Question: Describe this figure in one sentence.
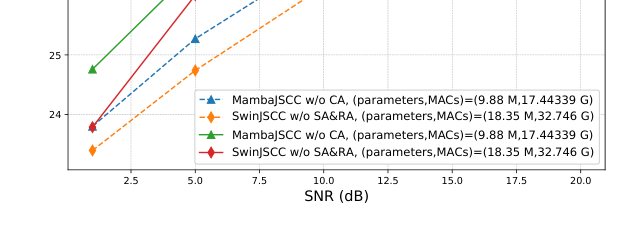
Answer: The PSNR performance of MambaJSCC w/o CA and SwinJSCC w/o SA&RA versus SNR under the AWGN and the Rayleigh fading channels. Nm and Ns are set to 6.